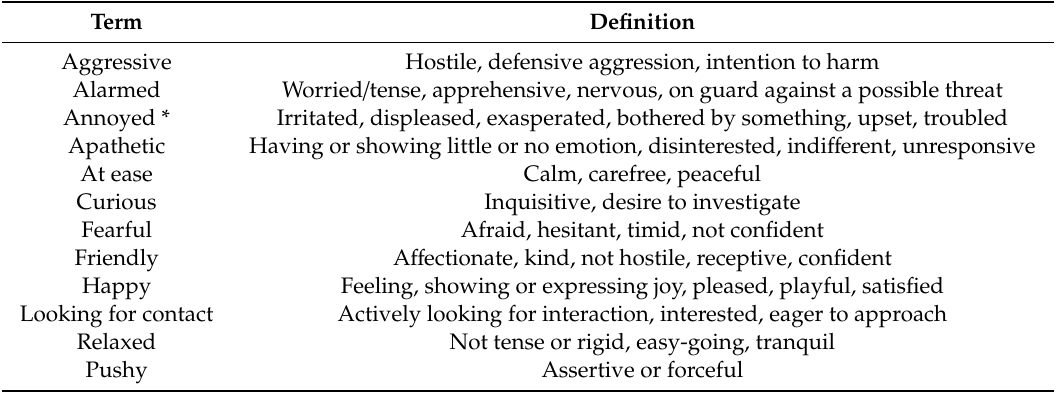
Table 1. Pre-selected terms used in the questionnaire to evaluate students’ understanding of horse behaviour, adapted from the AWIN